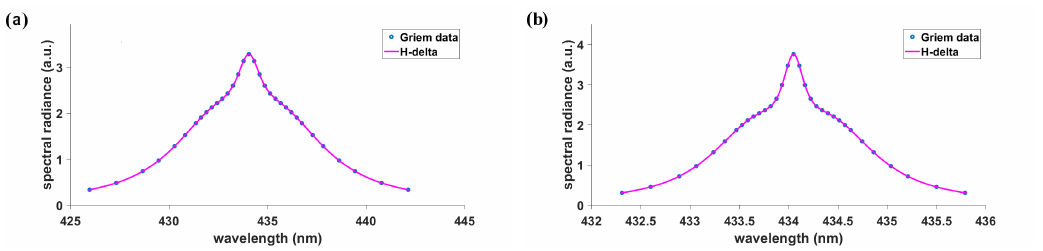
Figure 6. Line shapes of Balmer H γ at a temperature of 20 kK [21]. ( a ) N e = 1 × 10 17 cm − 3 , FWHM:6.0nm. ( b ) N e = 0.1 × 10 17 cm − 3 , FWHM: 1.15 nm.